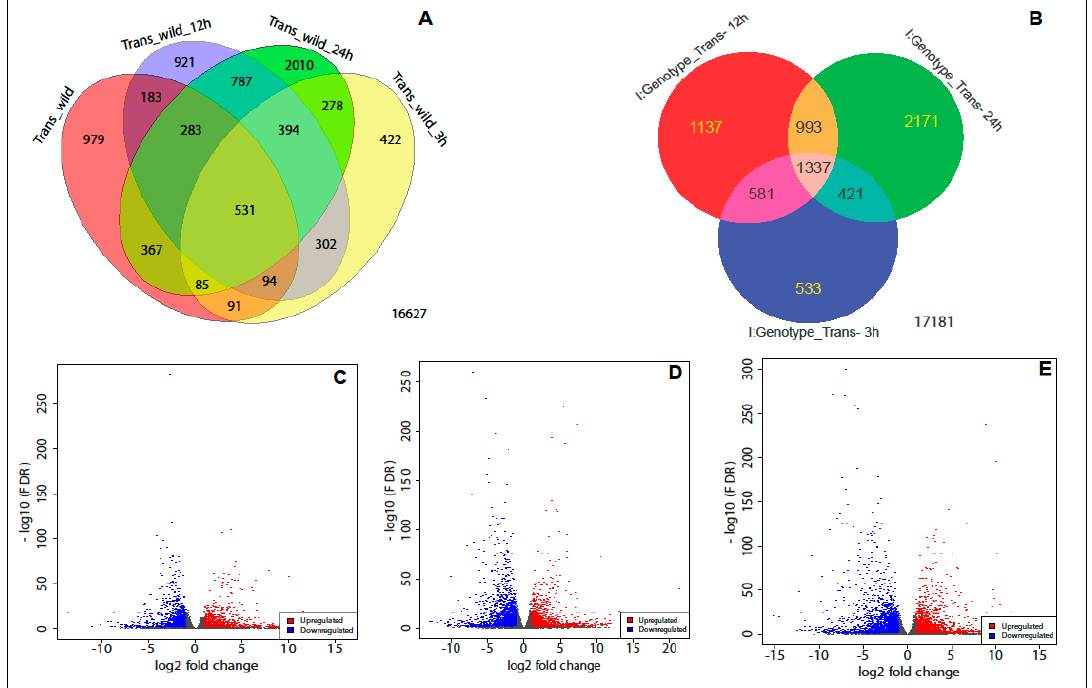
Figure 2. ( A ) Venn diagrams of the changes in differentially expressed genes in OxF3H (Trans) and “Wild” over time (0 h, 3 h, 12 h, and 24 h) of WBPH infection without interaction term; ( B ) Venn diagrams of the changes in differentially expressed genes only in OxF3H (Trans) over time (0 h, 3 h, 12 h, and 24 h) of WBPH infection; ( C ) volcano plot for differential expression analysis using DESeq2 after 3 h of WBPH infection in OxF3H plants; ( D ) volcano plot for differential expression analysis using DESeq2 after 12 h of WBPH infection in OxF3H plants; and ( E ) volcano plot for differential expression analysis using DESeq2 after 24 h of WBPH infection in OxF3H plants.